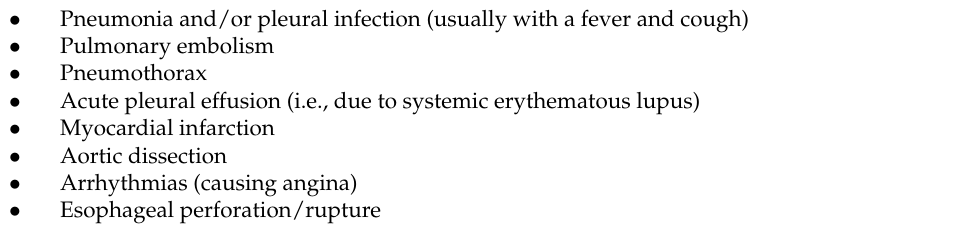
Table 1. Main causes of acute chest pain and shortness of